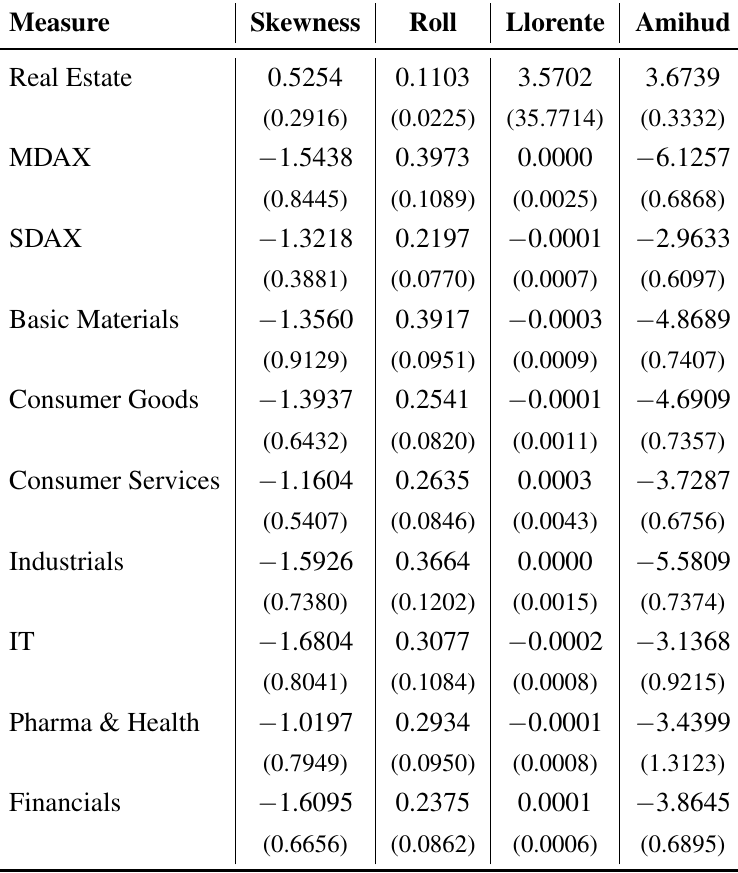
Table 2. Overview of information